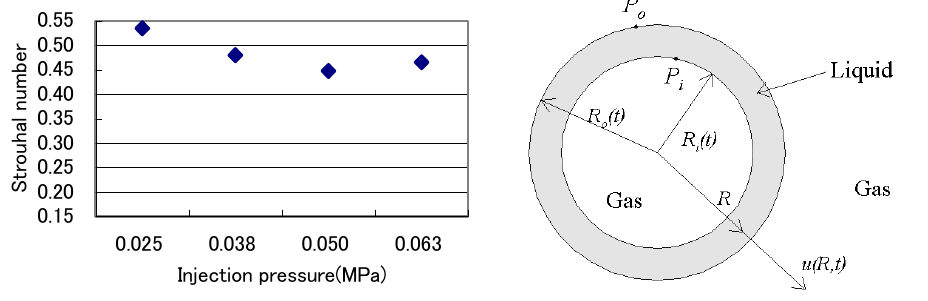
Fig. 9 Relation between St and injection pressure